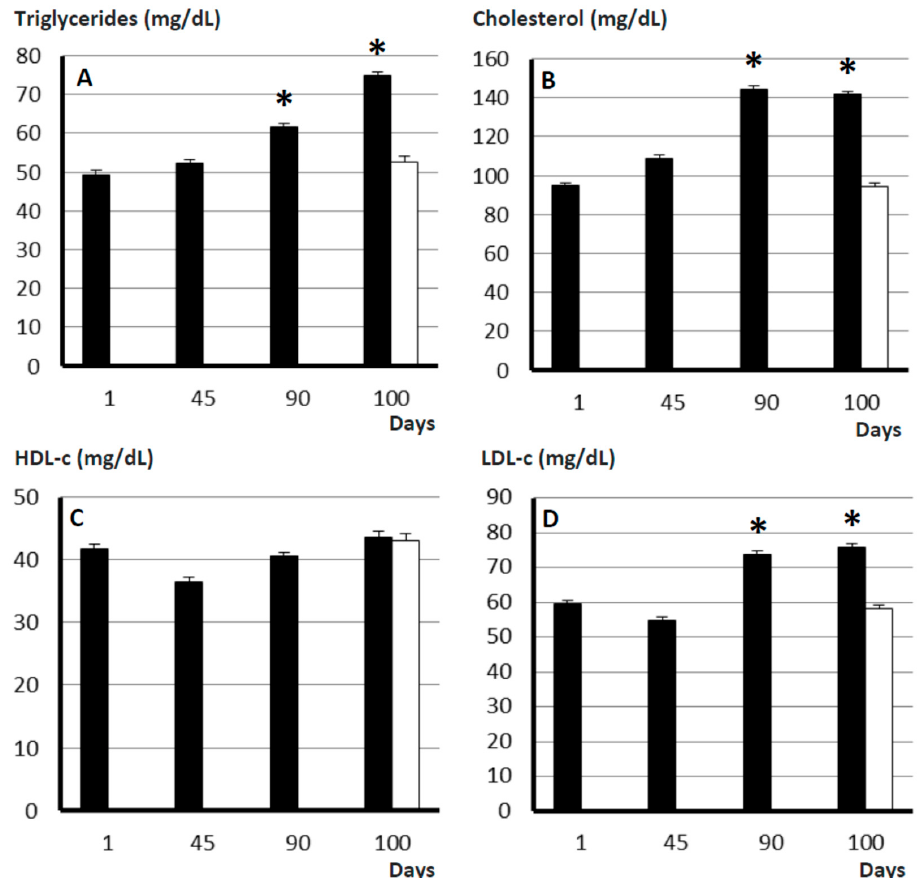
Figure 3. Mean ( ± S.E.M.) plasma concentrations of triglycerides ( A ), cholesterol ( B ), HDL-c ( C ) and LDL-c ( D ) in control sows (white bar; n = 17) and changes in such values over time after starting differential feeding with a diet enriched with saturated fat in treated sows (black bars; n = 11). Asterisks ( * ) denote significant differences between obese and non-obese sows ( p < 0.05).